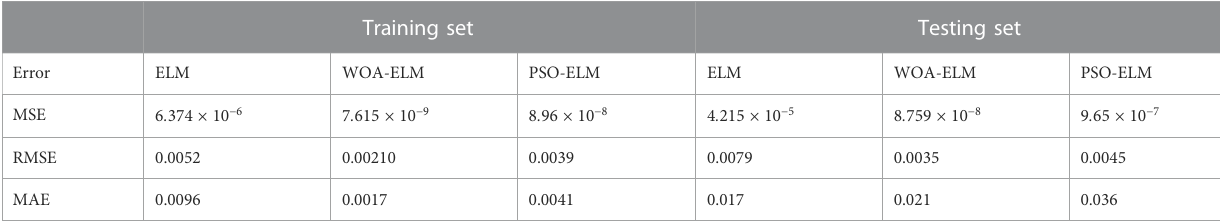
TABLE 4 Error between ELM and WOA-ELM methods in training and testing data